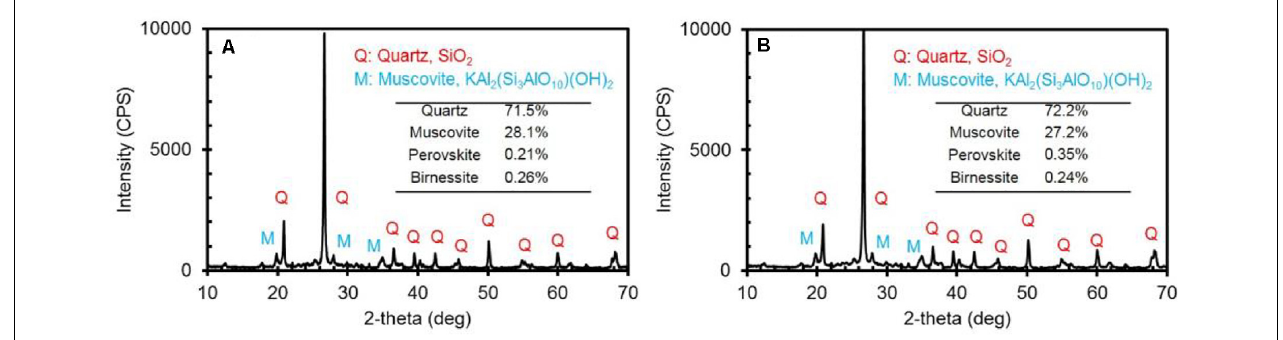
FIGURE 2 | XRD patterns of Fayetteville shale: (A) 106–250 µ m, washed by 1% acetic acid; (B) < 106 µ m, no wash.